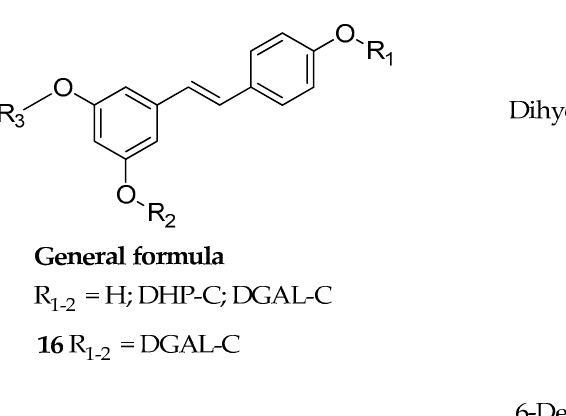
Figure 9. General formula of N- monosubstituted carbamoyl-RSV derivatives, and chemical structure of 16 .